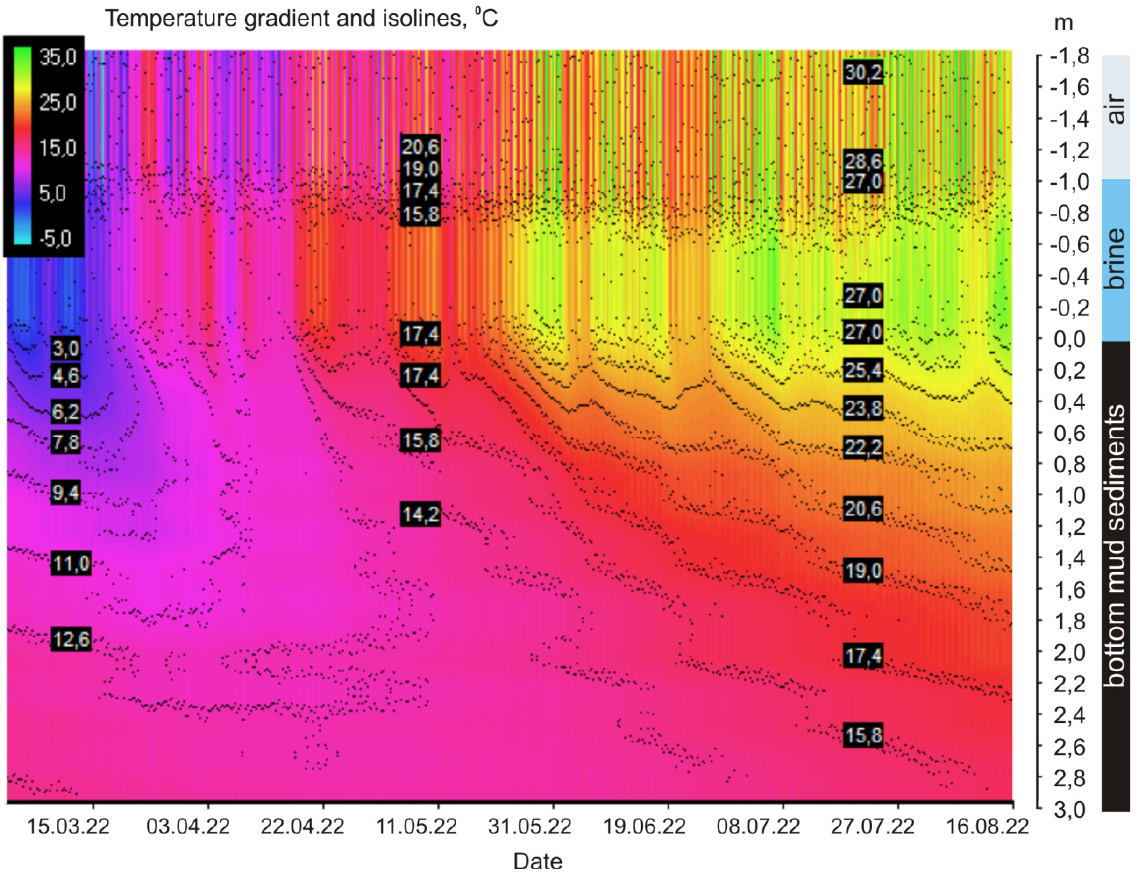
Figure 10. Seasonal dynamics of the measured vertical temperature profile during 200 days.